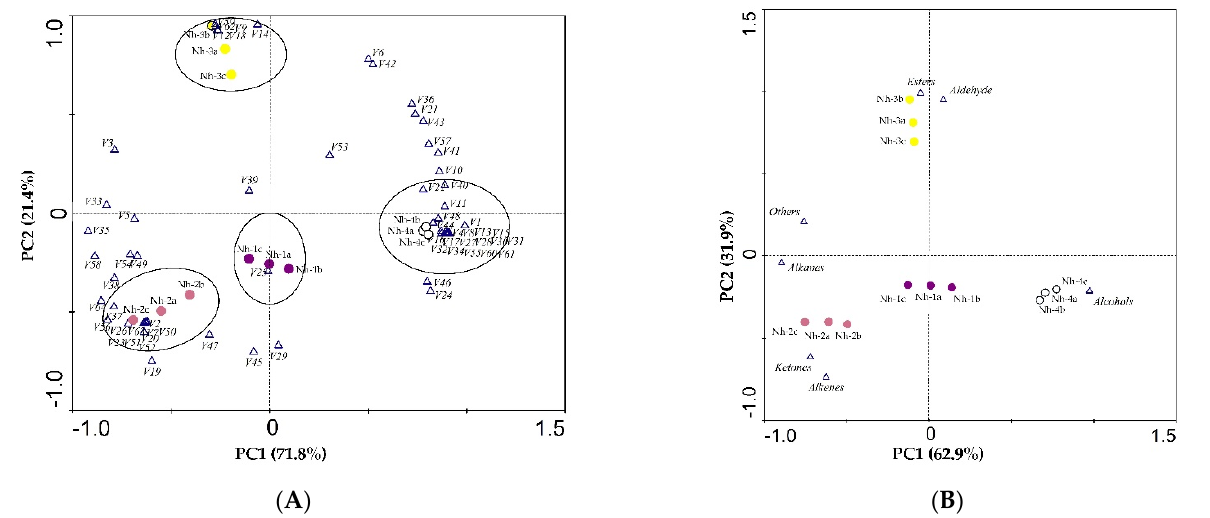
Figure 7. Principal component analysis (PCA) of 12 samples based on PC1 and PC2 scores. V1–V64 represented the volatile substances numbered 1–64 in Table 1. ( A ) Loading plot of samples and the 64 volatile compounds; ( B ) loading plot of samples and the seven different classes of volatile com ‐ pounds.